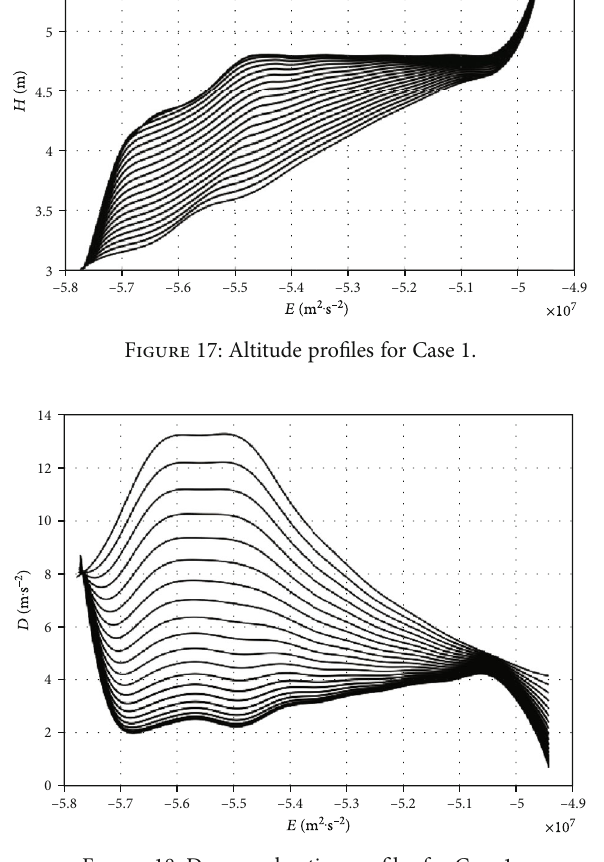
Figure 18: Drag acceleration pro fi les for Case 1.